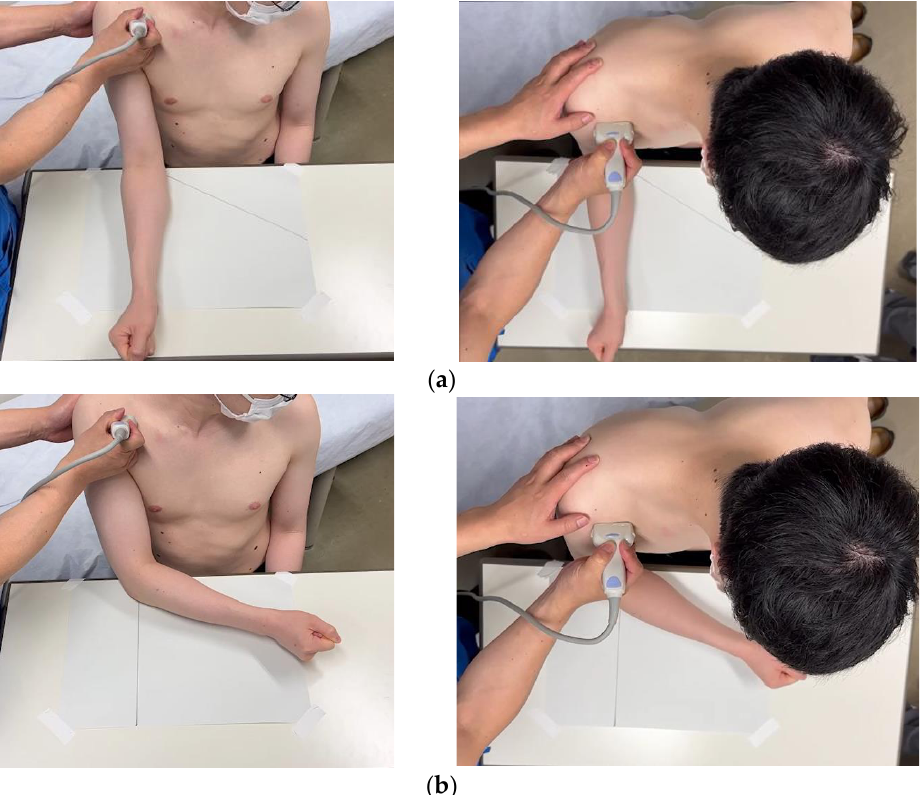
Figure 1. The coracoid process was identified from the body surface, and the CHL’s long-axis image was drawn parallel to the subscapularis tendon. Active shoulder joint movement in the spontaneous drooping position was performed from 0 to 60 degrees of internal rotation. ( a ) Position N (0 degrees of internal rotation) and ( b ) position IR (60 degrees of internal rotation).